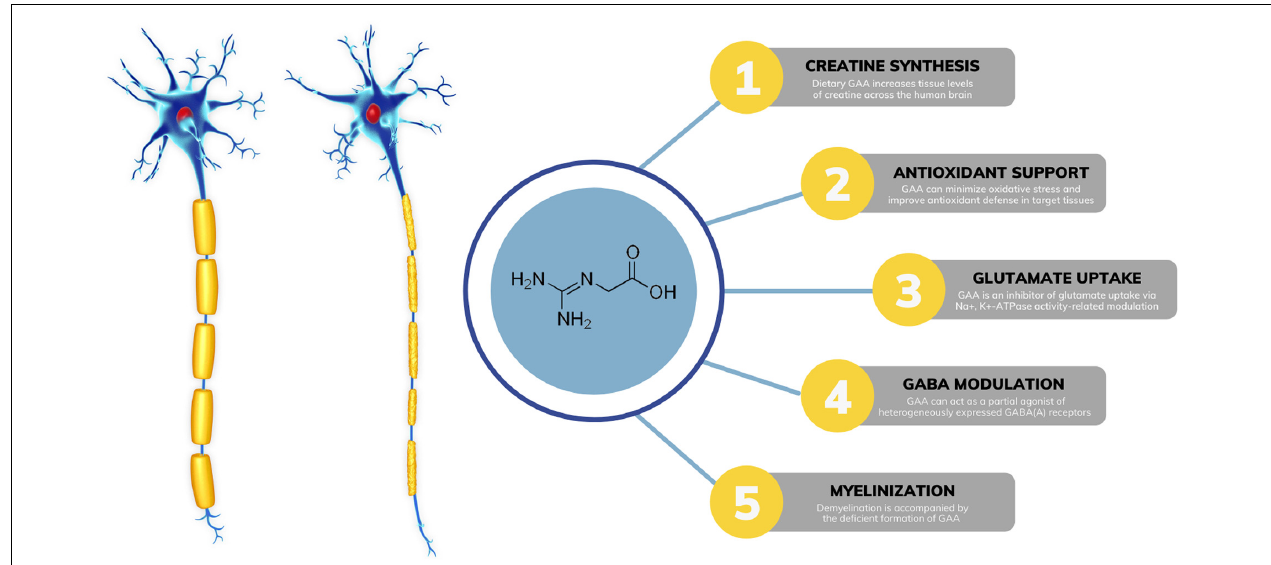
FIGURE 1 | Possible mechanisms of guanidinoacetic acid (GAA) action in multiple sclerosis. GABA, gamma-aminobutyric acid; ATP, adenosine